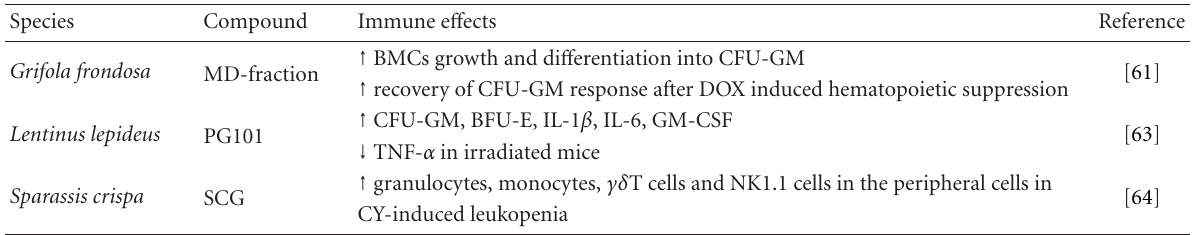
Table 1. Immunomodulatory activities of mushroom compounds on hematopoietic stem cells. Species